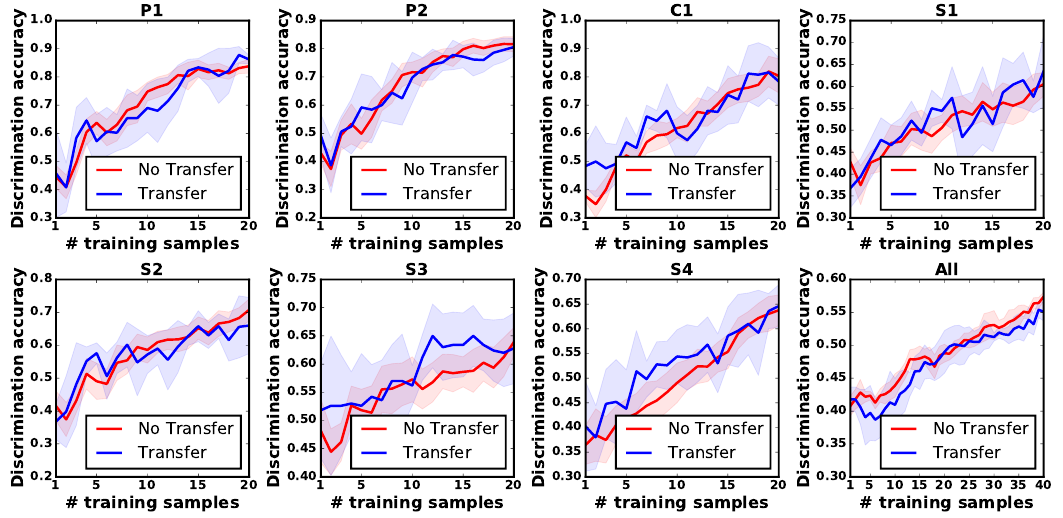
Figure 11. Negative prior tactile knowledge transfer testing. The prior objects that were unrelated to the new objects were deliberately